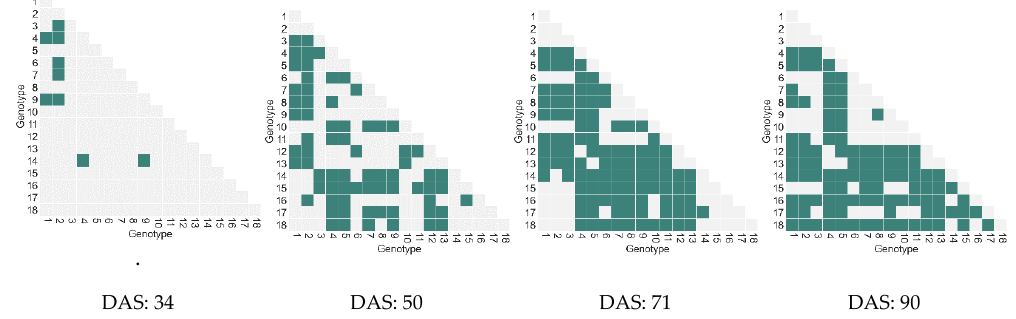
Figure 12. Multiple-comparison Tukey’s test for the LiDAR-based volume for the 18 genotypes planted in HyCal-18 experiment collected throughout the 2018 growing season. Green shows the two varieties are significantly different from each other (α = 0.05).